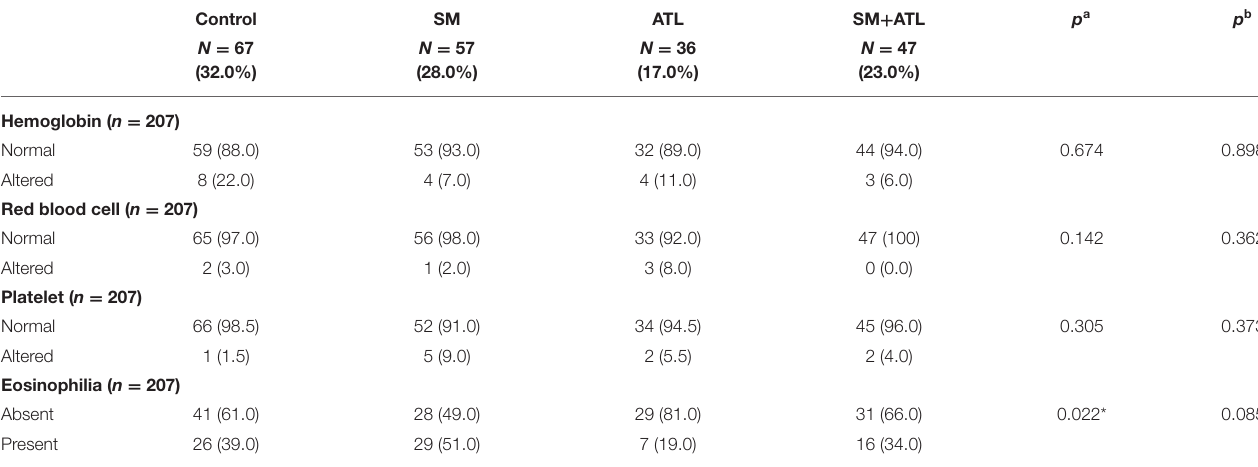
TABLE 3 | Frequency of normal and altered values for hemoglobin, red blood cells, platelets, and eosinophils in individuals with different parasitic status living in the rural community of Brejo do Amparo, Januária, Minas Gerais, Brazil. Control SM